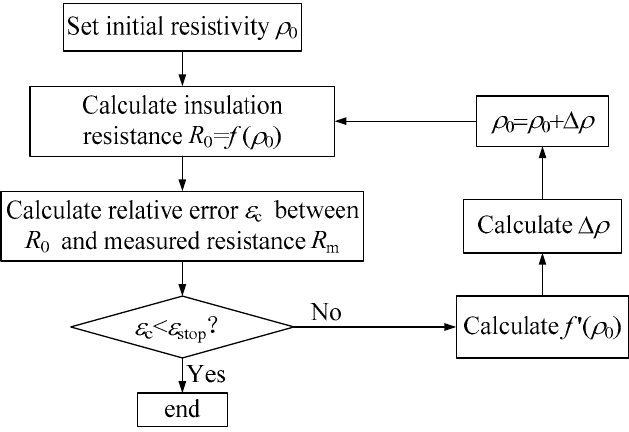
Figure 9. Flowchart of Newton’s method for iterative calculation of paper resistivity.